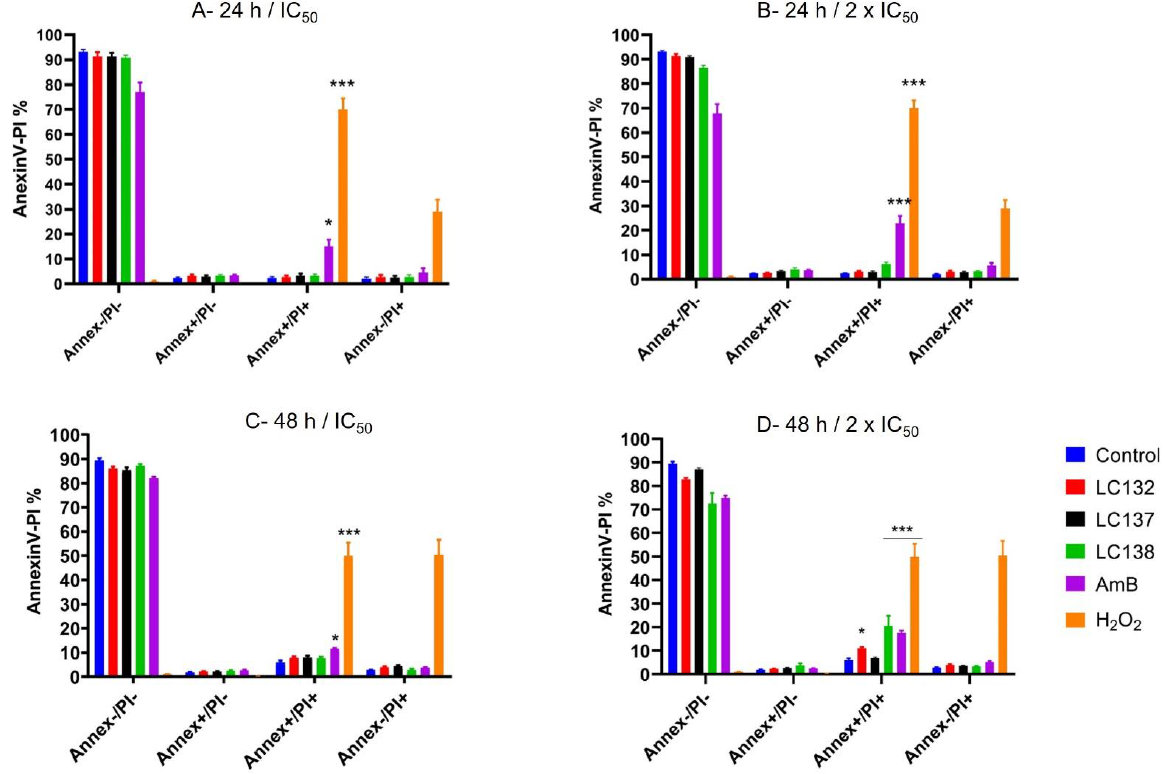
Figure 1. Flow cytometry analysis of phosphatidylserine externalization after 24 h ( A , B ) and 48 h ( C , D ) treatment of L. infantum promastigotes with IC 50 LC132 (13.0 µM), LC137 (137.0 µM), LC138 (125.4 µM) or AmB (0.2 µM) and 2 × IC 50 LC132 (25.9 µM), LC137 (274.0 µM), LC138 (250.8 µM or AmB (0.3 µM). Percentages correspond to Annexin V (Annex) and Propidium iodide (PI) cell populations: Annex − /PI − , live cells; Annex+/PI − , early apoptotic cells; Annex+/PI+, late apoptotic cells; Annex − /PI+, necrotic cells. 2 mM H 2 O 2 was used as control for apoptosis. Data are represented by mean ± standard error of mean (SEM) of three independent experiments, with triplicates. Asterisks represent statistically significant differences of apoptotic populations related to Control (non-treated parasites) * p < 0.05; *** p <